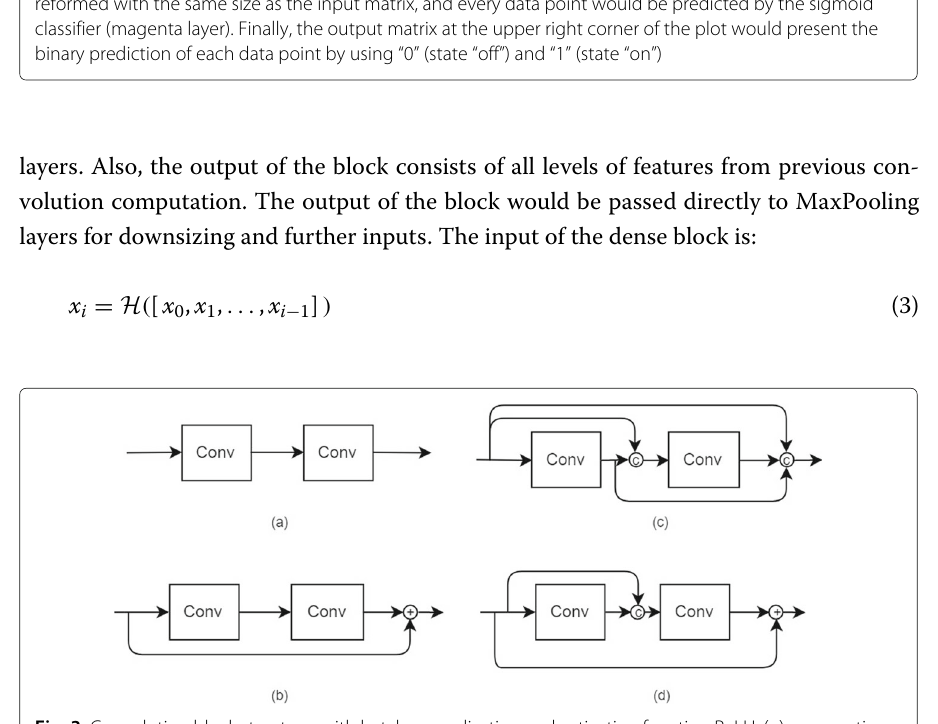
Fig. 3 Convolution block structure, with batch normalization and activation function ReLU: ( a ) consecutive convolutional layers; ( b ) a residual block; ( c ) a dense block; ( d ) a residual-dense